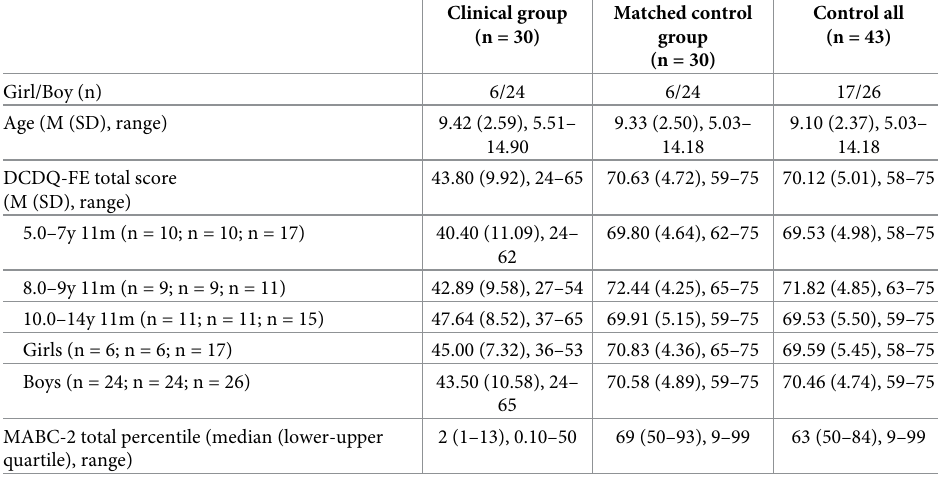
Table 1. Swiss groups’ characteristics, DCDQ-FE and MABC-2